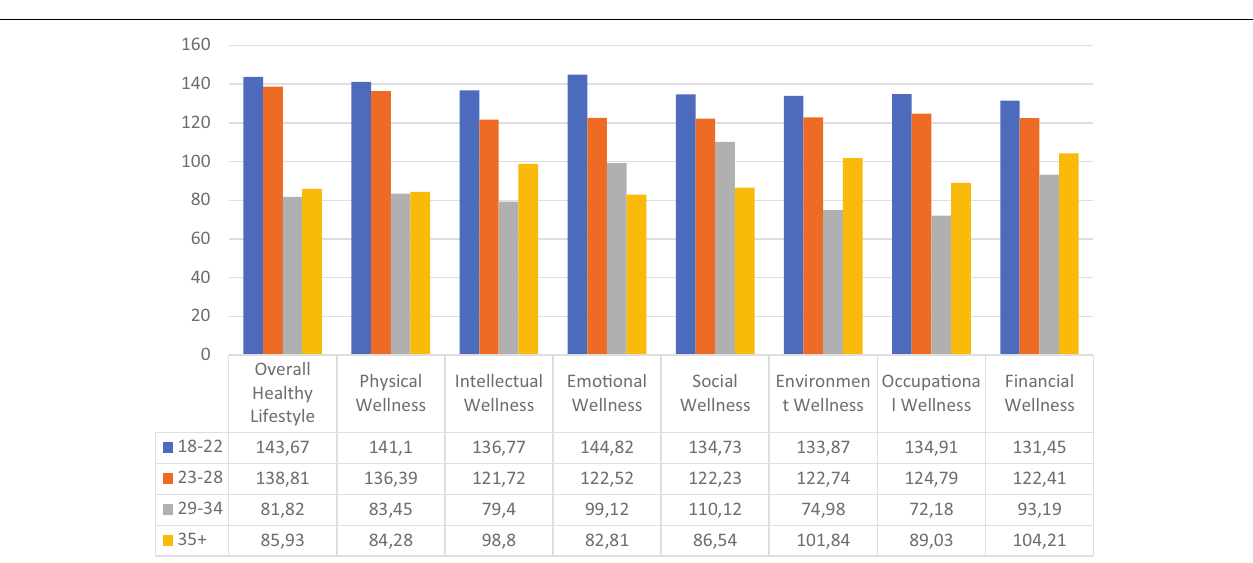
FIGURE 2 | Ranks of the different wellness dimensions by